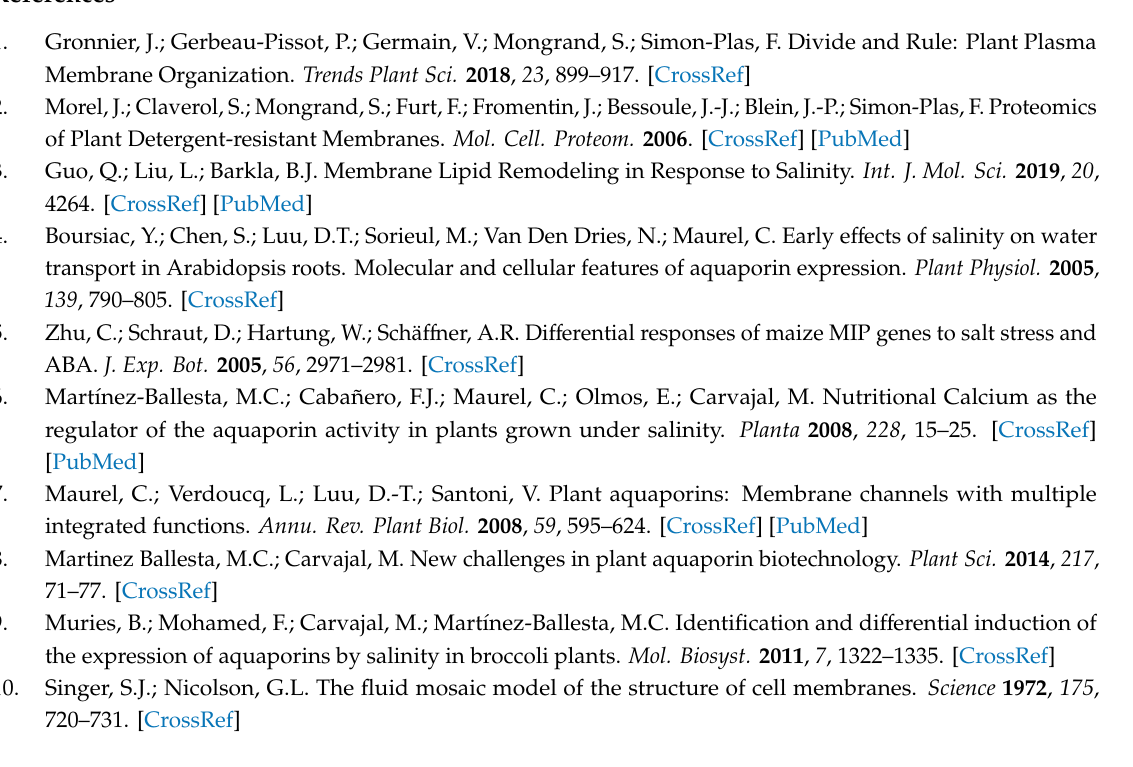
Figure S1: 12% SDS-PAGE stained with Coomassie Brilliant Blue of purified DRMs proteins isolated from roots of control and NaCl-treated broccoli plants. Table S1: Proteins identified in detergent resistant membranes (DRMs) isolated from control broccoli roots, after database search. Where MW is molecular weight (in dalton), PSMs is the number of fragmentation spectra acquired, peptides; the number of distinct peptide sequences in the protein group, emPAI is Exponentially Modified Protein Abundance Index and coverage; the percentage of the protein sequence covered by identified peptides. Table S2: Proteins identified in detergent resistant membranes (DRMs) isolated from NaCl (80 mM) broccoli roots, after database search. Where MW is molecular weight (in dalton), PSMs is the number of fragmentation spectra acquired, peptides; the number of distinct peptide sequences in the protein group, emPAI is Exponentially Modified Protein Abundance Index and coverage; the percentage of the protein sequence covered by identified peptides. Table S3: Proteins identified in detergent resistant membranes (DRMs) isolated from control and NaCl (80 mM) broccoli roots, after database search. Where MW is molecular weight (in dalton), PSMs is the number of fragmentation spectra acquired, peptides; the number of distinct peptide sequences in the protein group, emPAI is Exponentially Modified Protein Abundance Index and coverage; the percentage of the protein sequence covered by identified peptides. Table S4: Enzymatic activities (nmol min − 1 mg − 1 Protein) of control PM and microsomal fractions measured in the supernatant of the purification after aqueous polymer two-phase partitioning